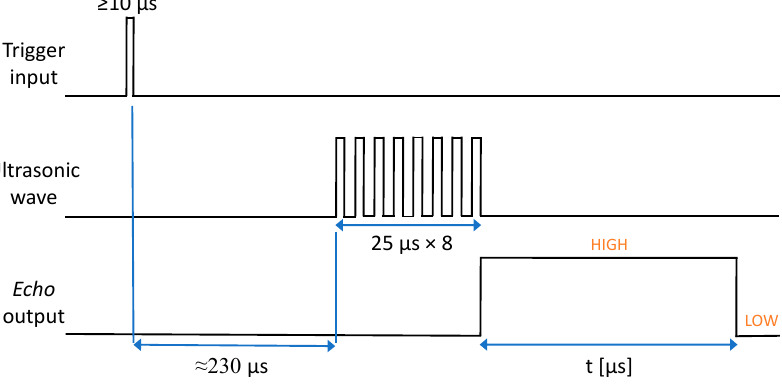
Figure 2. Operation scheme of the HY-SRF05.